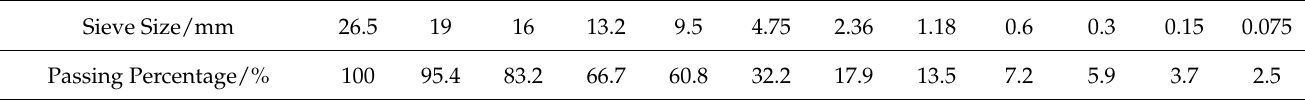
Table 1. Results of sieving for RAP.